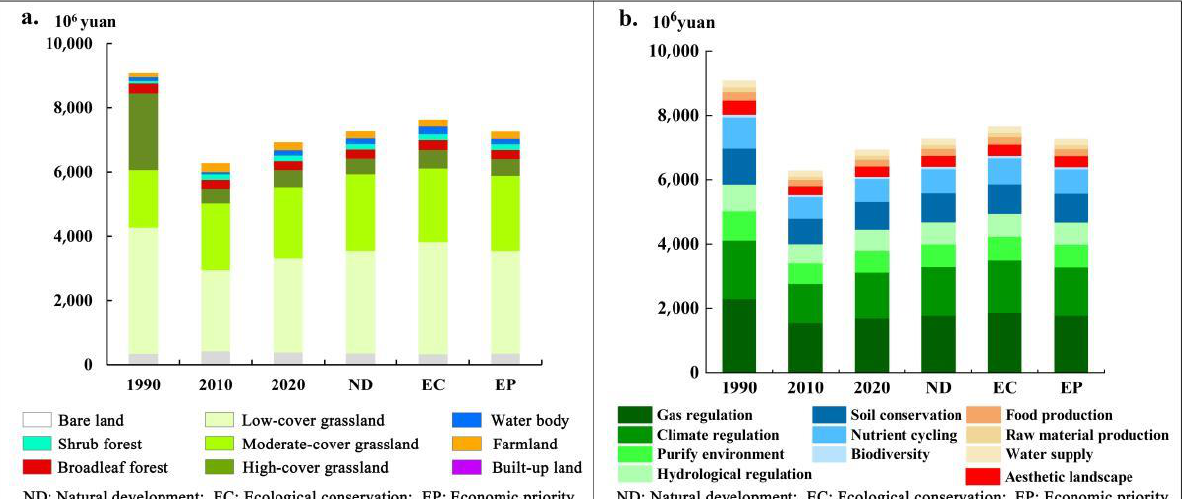
Figure 4. Ecosystem service values (ESV) from 1990 to 2030. ( a ) For the different land use types; ( b ) for the different service types.